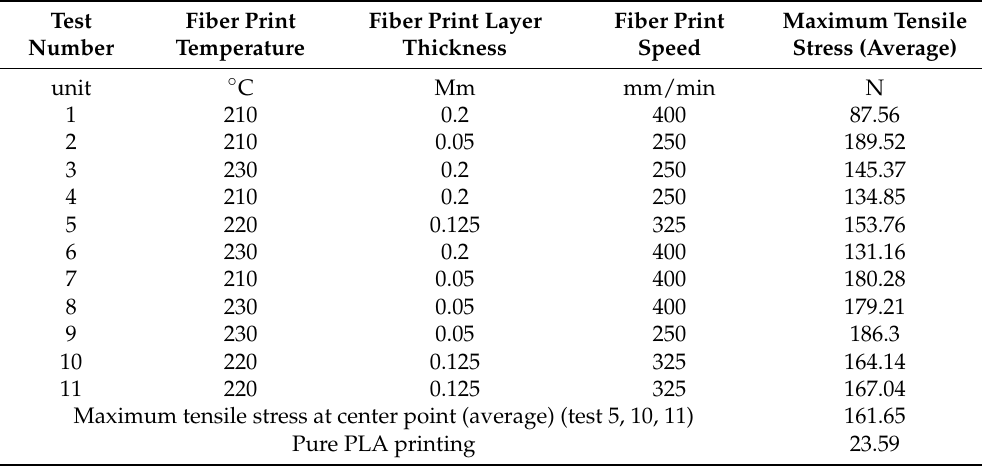
Table 4. Experimental scheme and results.